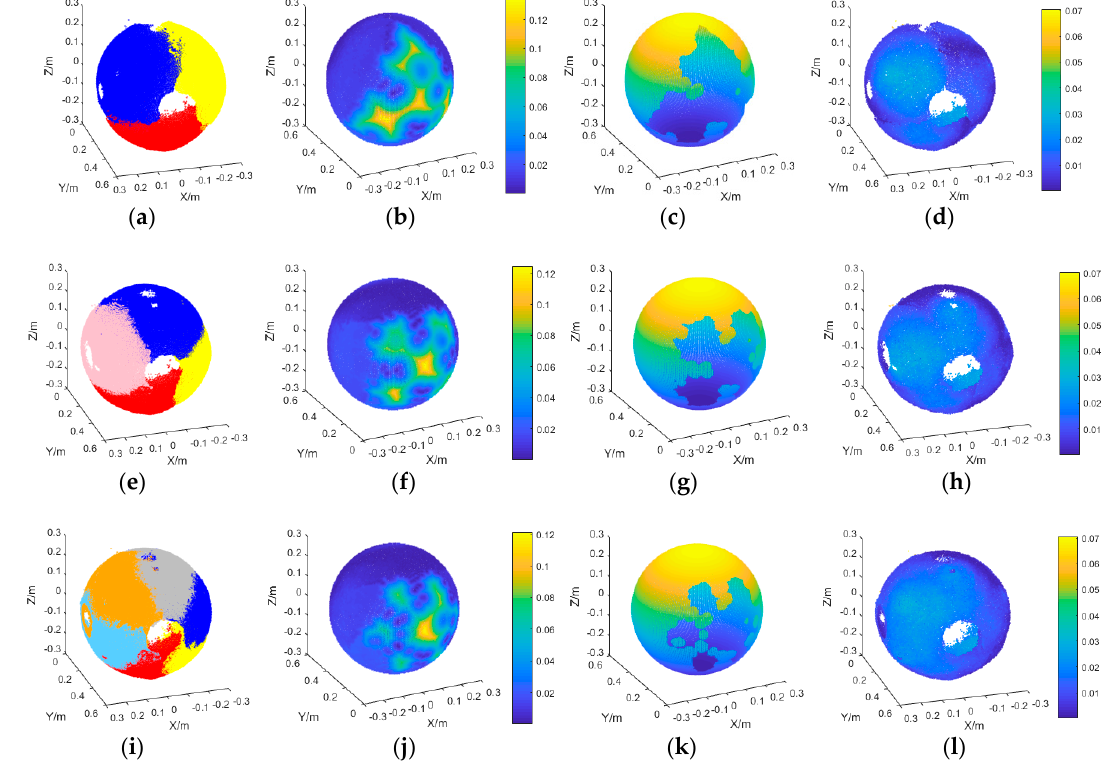
Figure A2. Reconstructed 3D point cloud of the SSB and reconstruction accuracy analysis. ( a ) point cloud of the SSB reconstructed based on images captured at three AOVs, ( b ) H SR set, ( c ) area covered by